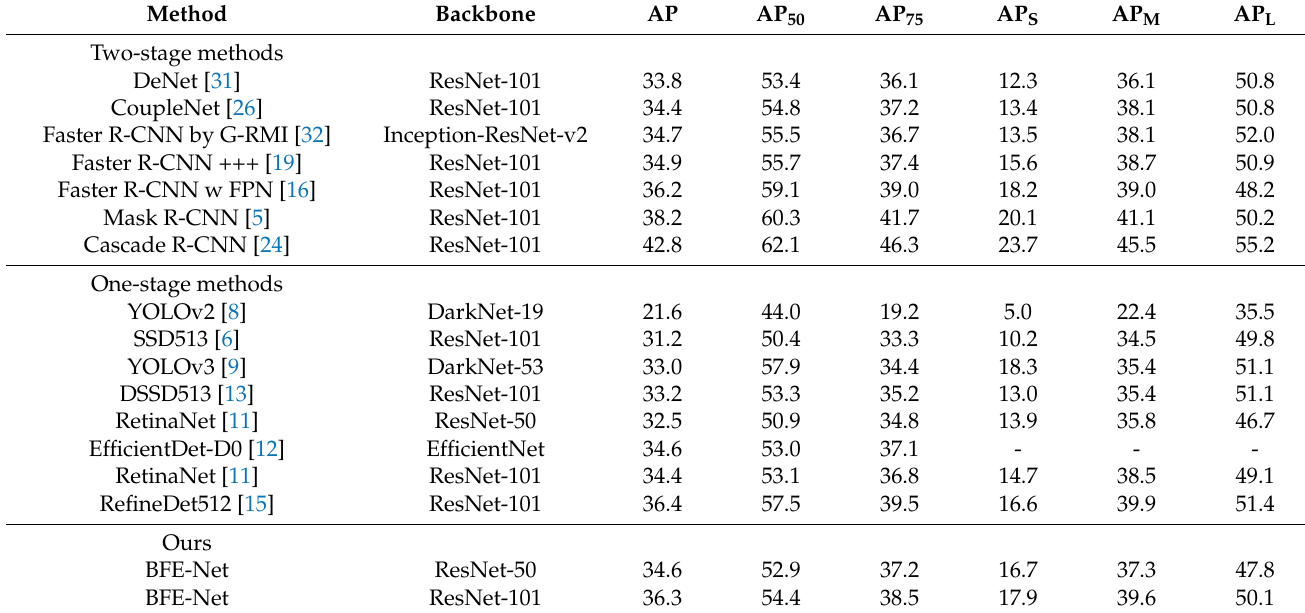
Table 1. BFE-Net vs. other two-stage and one-stage detectors on COCO